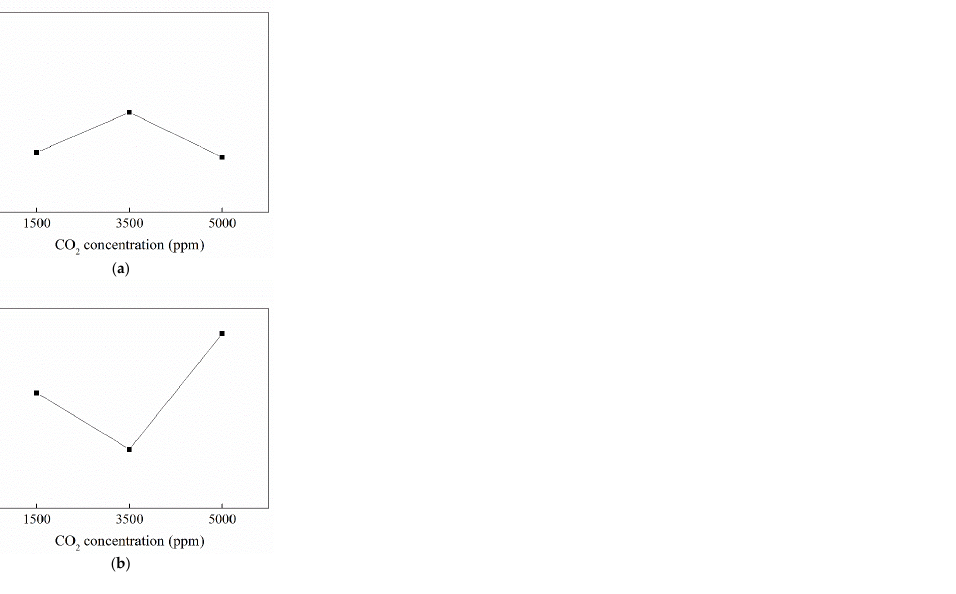
Figure 5. Performance metrics of the 2-back test under different CO 2 conditions. ( a ) Accuracy. ( b ) Response time.